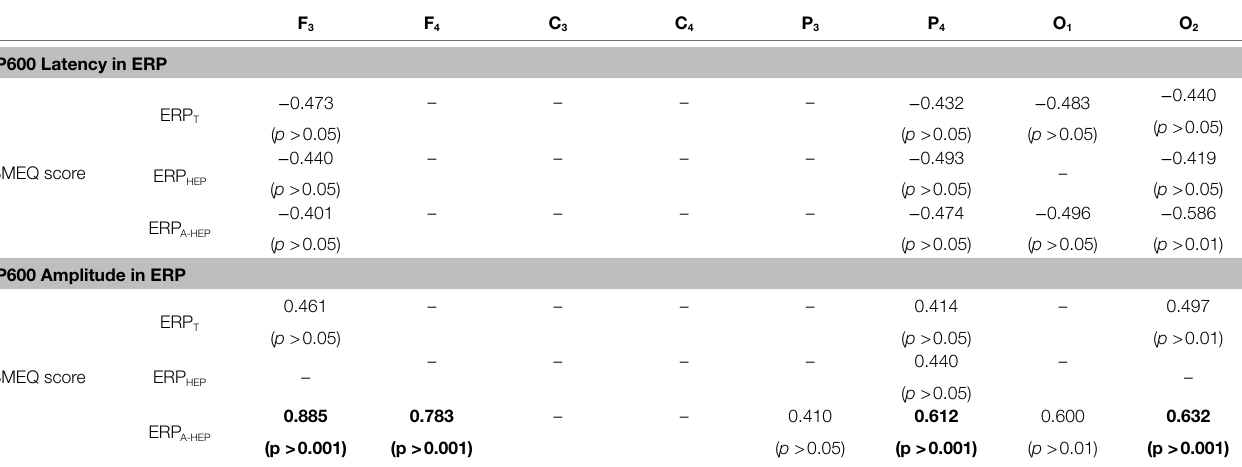
TABLE 4 | Partial correlation analysis between ERP features and SMEQ scores for each condition (ERP T , ERP HEP , and ERP A-HEP ). F 3 F 4 C 3 C 4 P 3 P 4 O 1 O 2 P600 Latency in ERP